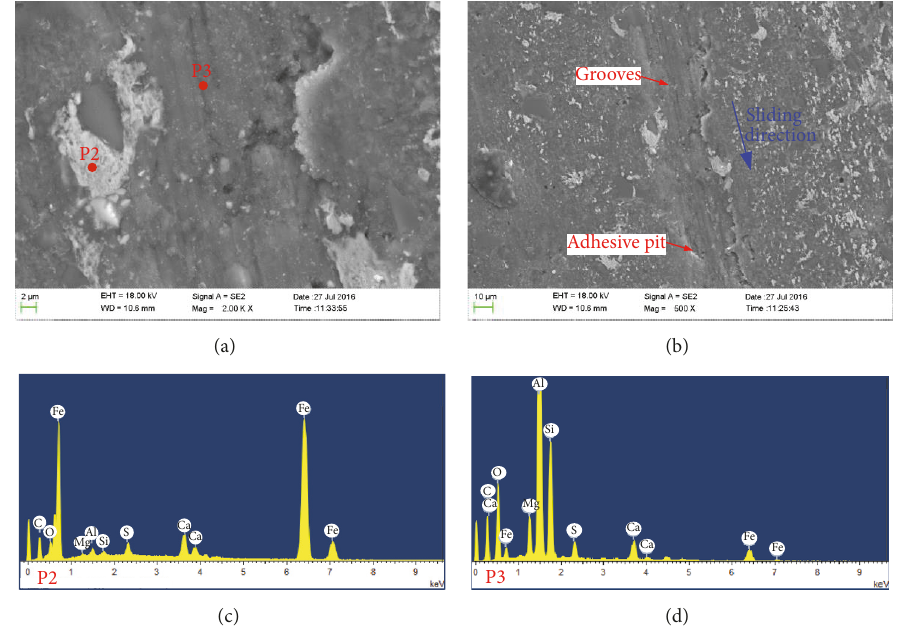
Figure 10: The surface topography and EDS of composites specimen for the test of 30 ∘ C ∼ 300 ∘ C: (a) 200x, (b) 500x, (c) EDS of position P2, and (d) EDS of position